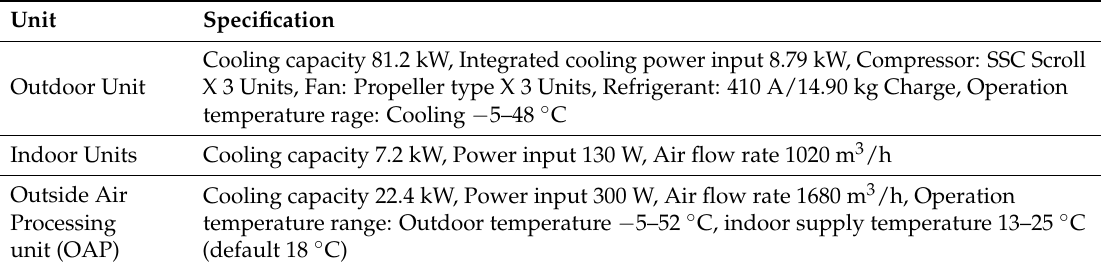
Table 2. Specification of VRF-OAP system.